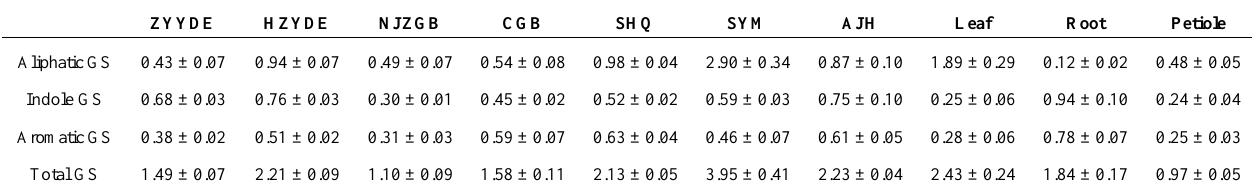
Table 1. Aliphatic, indole and aromatic glucosinolates content (µmol) in shoots of different cultivars and in different organs of “Hangzhou You Dong Er” cultivar. Data are the means of three biological repeats ± standard